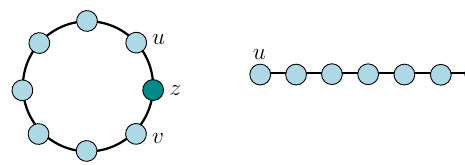
Figure 6 Extracting a Hamiltonian path from a Hamiltonian